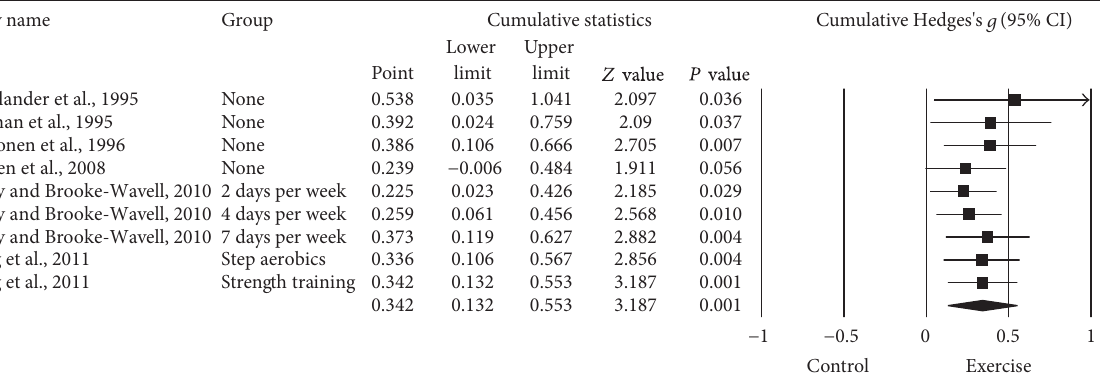
F 4: Cumulative meta-analysis for changes in FN BMD. Cumulative meta-analysis, ordered by year, for point estimate standardized effect size changes ( ) in FN BMD. e black squares represent the standardized mean difference ( squares represent the corresponding 95 con�dence intervals. e results of each corresponding study are pooled with all studies preceding it. e middle of the black diamond represents the overall standardized mean difference ( 𝑔𝑔 represent the corresponding 95 con�dence intervals. Negative results favor control groups while positive results favor exercise groups. % %